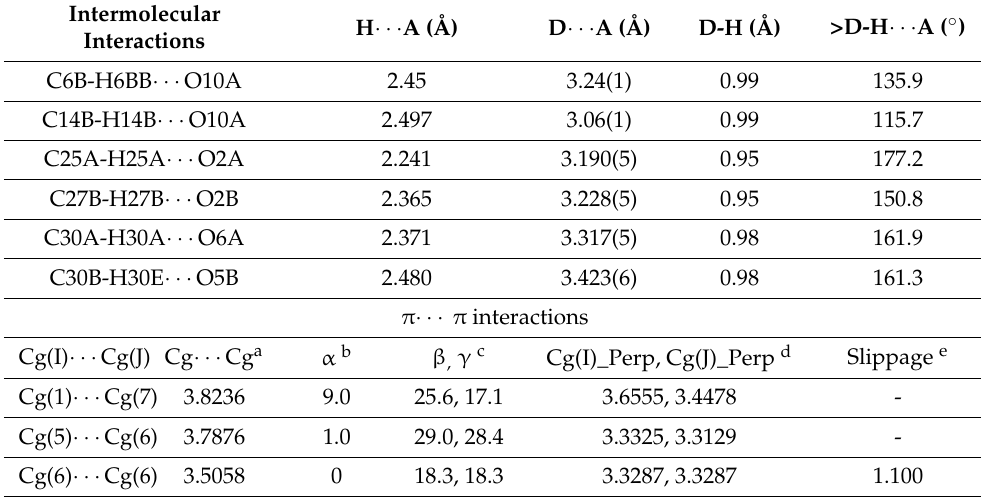
Table 6. Intermolecular interactions in 3 . Intermolecular Interactions